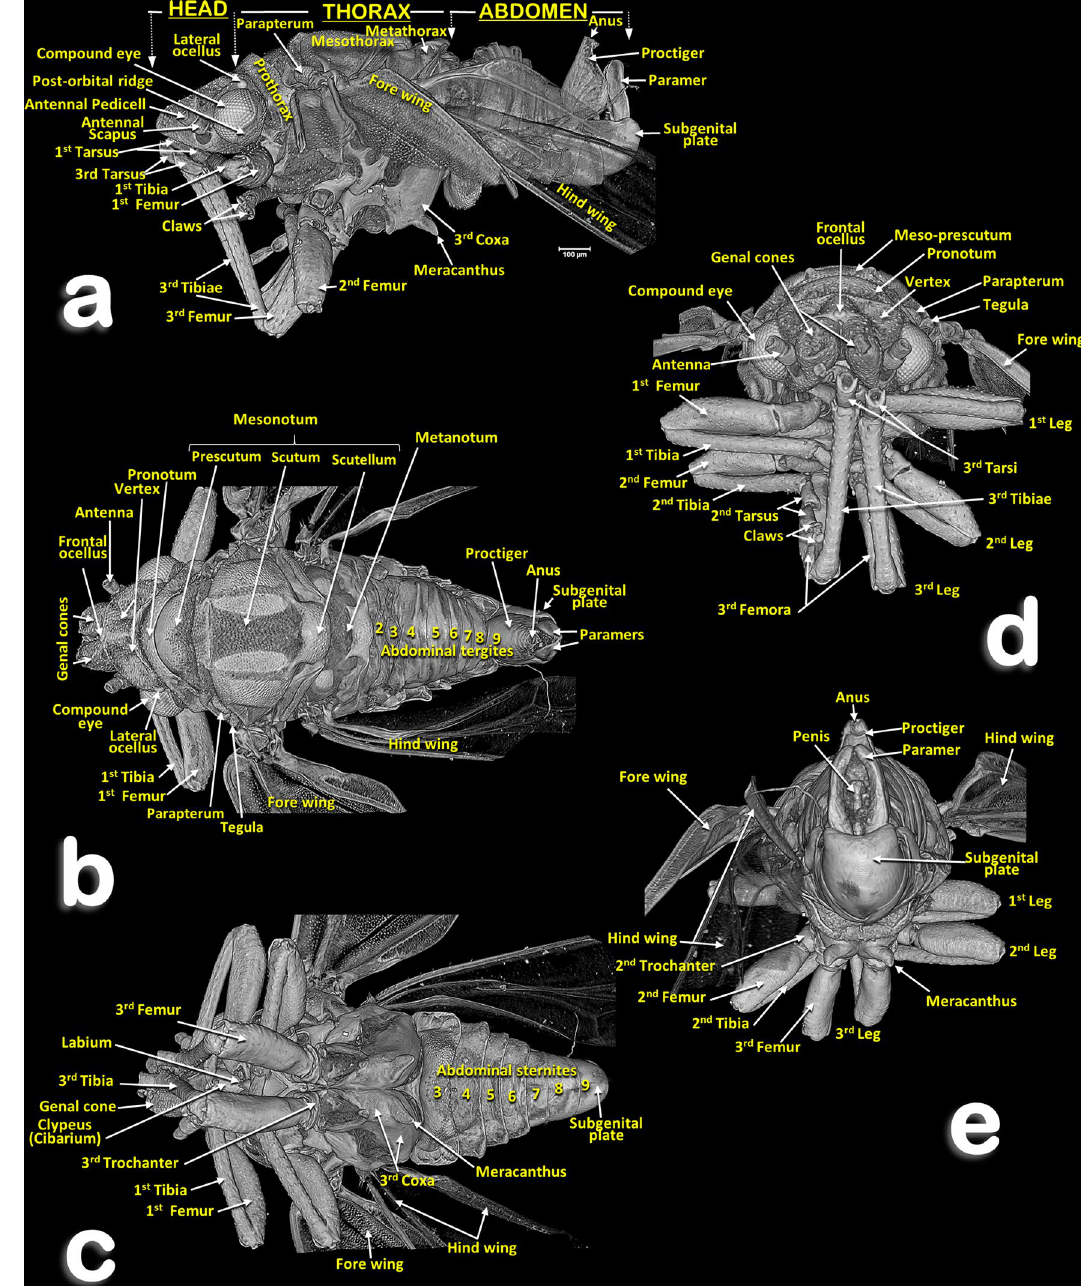
Figure 1. Volume-rendered images of the general external anatomy of a male Diaphorina citri in different views. Left-lateral ( a ), dorsal ( b ), ventral ( c ), frontal ( d ) and posterior ( e